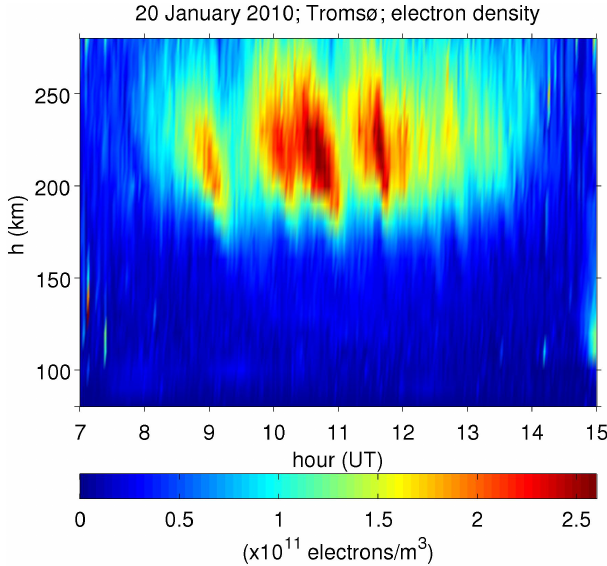
Figure 1. Electron density measured on 20 January 2010 from EISCAT in